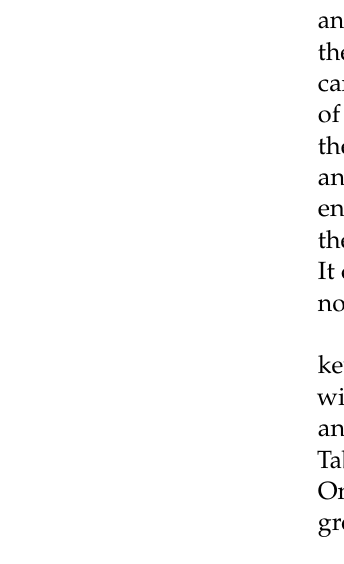
on the research results.